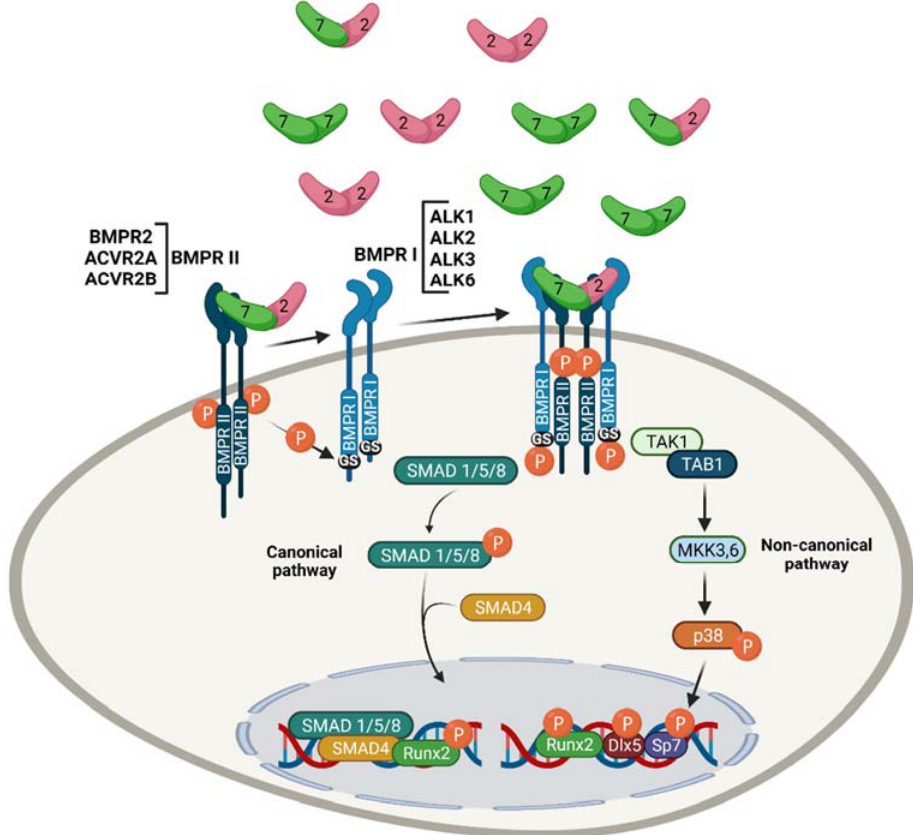
Figure 1. Overview of BMP signalling cascades. BMP homodimers and heterodimers signal through a heterotetrameric complex of serine/threonine kinase BMP type I and type II receptors. In the induced heterotetrameric complex, BMPR type II phosphorylates the GS-domain of BMPR type I to induce canonical and noncanonical BMP signalling pathways. In the canonical pathway, type I receptors phosphorylate Smads 1, 5, or 8 (R-Smad), which form a heteromeric complex with Smad 4, and then translocate to the nucleus. In the nucleus, this complex forms a complex with Runx2 to regulate osteogenic gene expression. The noncanonical signalling cascade, p38 mitogen-activated protein kinase (MAPK), is initiated by TAK1 phosphorylation, which recruits TAB1 and induces the MKK-P38 MAPK signalling pathway. The phosphorylated form of p38 phosphorylates and activates Runx2, Dlx5, and Sp7 transcription factors in the nucleus to initiate the transcription of osteogenic genes. Furthermore, phosphorylated Runx2 promotes the formation of the Smad–Runx2 complex. “Created with BioRender.com (Accessed on 31 January